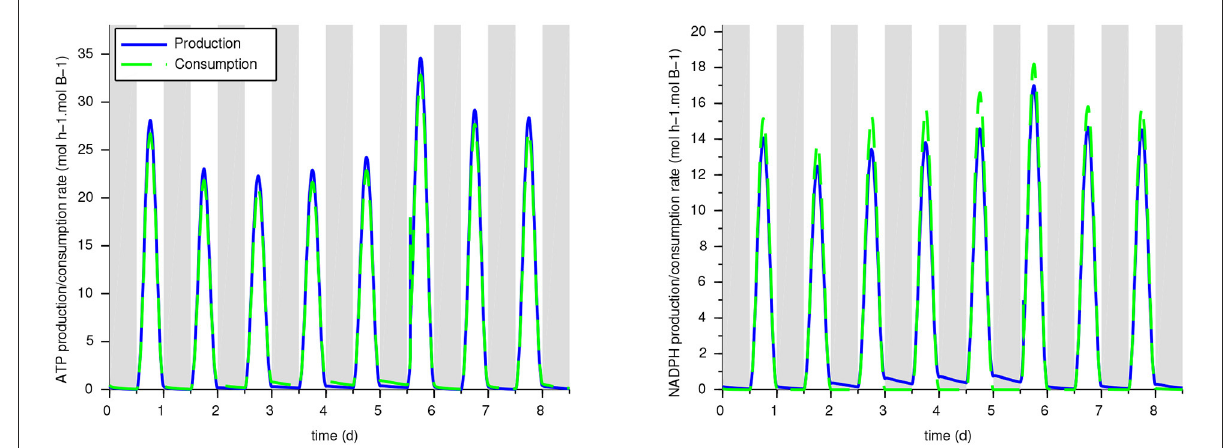
FIGURE6 Production and consumption rates for ATP and NADPH with the ExCARB model. The ATP and NADPH balances—not imposed in the model—are validated a